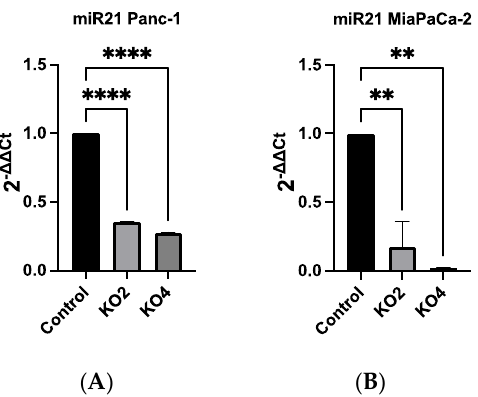
Figure 2. miR-21 expression levels are significantly reduced in Panc-1 and MiaPaCa-2 Kos. ( A ) Rel- ative expression levels of miR-21 in miR-21 KO Panc-1 cells. miR-21 expression levels of miR-21 knockout clone 2 (KO2) and miR-21 knockout clone 4 (KO4) cell colonies were downregulated sig- nificantly compared to untreated control Panc-1 cells ( n = 3; p < 0.0001 for all). The column graphic represents the average of three replicates of RNA isolated from the Panc-1 control and its Kos. Data normalized according to RNU6 expression by fold analysis ( n = 3, p < 0.05). ( B ) Relative expression levels of miR-21 in miR-21 KO MiaPaCa-2 cells. miR-21 expression levels of miR-21 knockout clone 2 (KO2) and miR-21 knockout clone 4 (KO4) cell colonies were reduced significantly compared to untreated control MiaPaCa-2 cells ( n = 3; p < 0.01 for all). The column graphic represents the average of three replicates of RNA isolated from MiaPaCa-2 control and its Kos. Data normalized according to RNU6 expression by fold analysis ( n = 3, p < 0.05). p -values are indicated as: ** p ≤ 0.01; **** p ≤ 0.0001; error bars indicate SD.